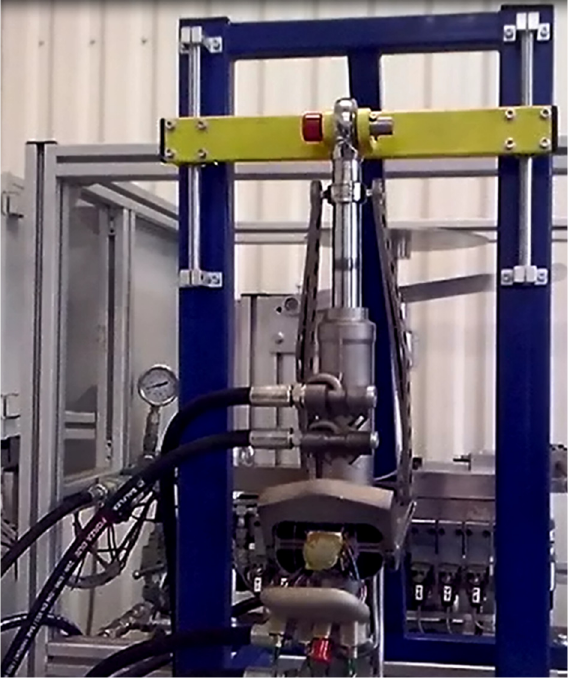
Figure 15. The actuator prototype prepared for preliminary functional tests.